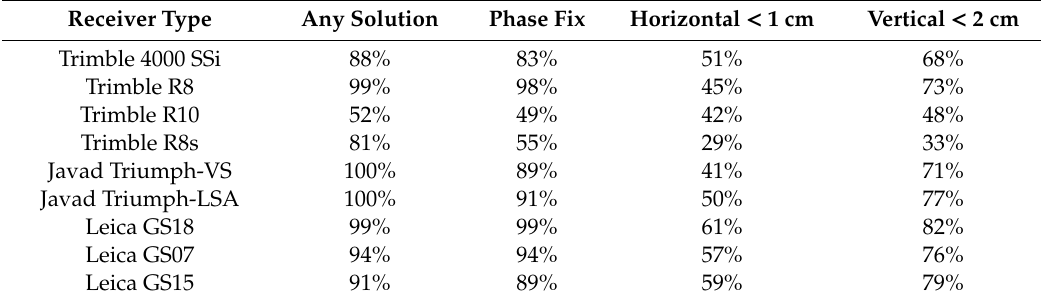
Table 5. Percentage of the successful ambiguity fixing from 8:20 to 10:00 UTC, i.e., during static and kinematic jammings.